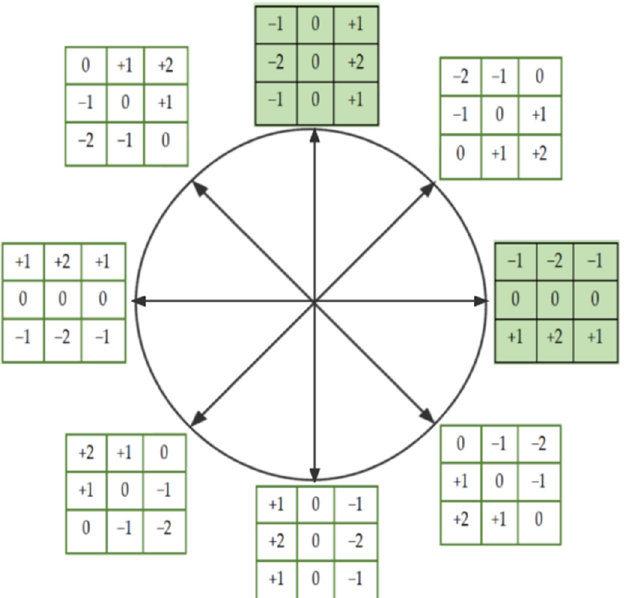
Figure 7. Improved Sobel operator.